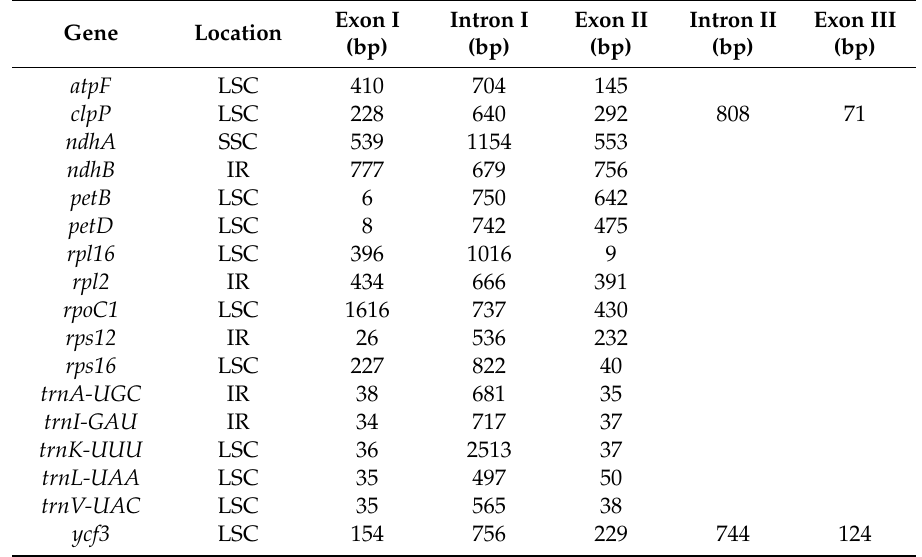
Table 3. Gene in the chloroplast genome of L. chinense with introns and